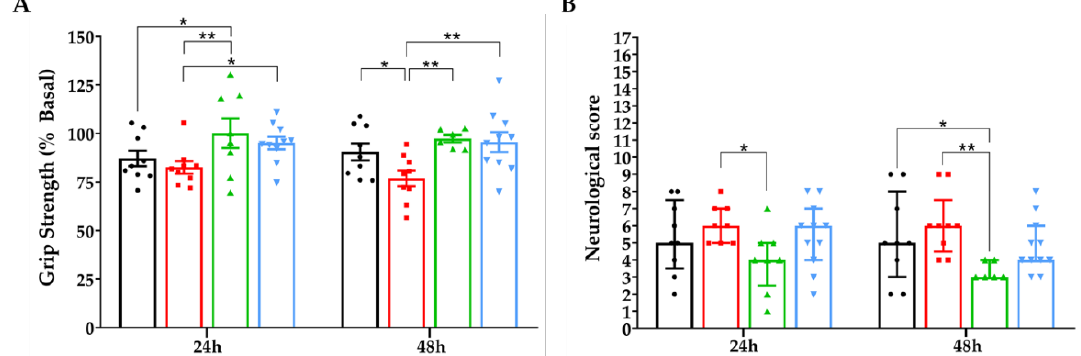
Figure 7. Di ff erences in motor deficits and neurological function in mice fed with HFD-OO or Figure 7. Differences in motor deficits and neurological function in mice fed with HFD-OO or HFD- HFD-OO- ω 3. Groups: LFD (Black), HFD-SFA (Red), HFD-OO (Green), and HFD-OO- ω 3 OO-ω3. Groups: LFD (Black), HFD-SFA (Red), HFD-OO (Green), and HFD-OO-ω3 (Blue). ( A ) HFD-